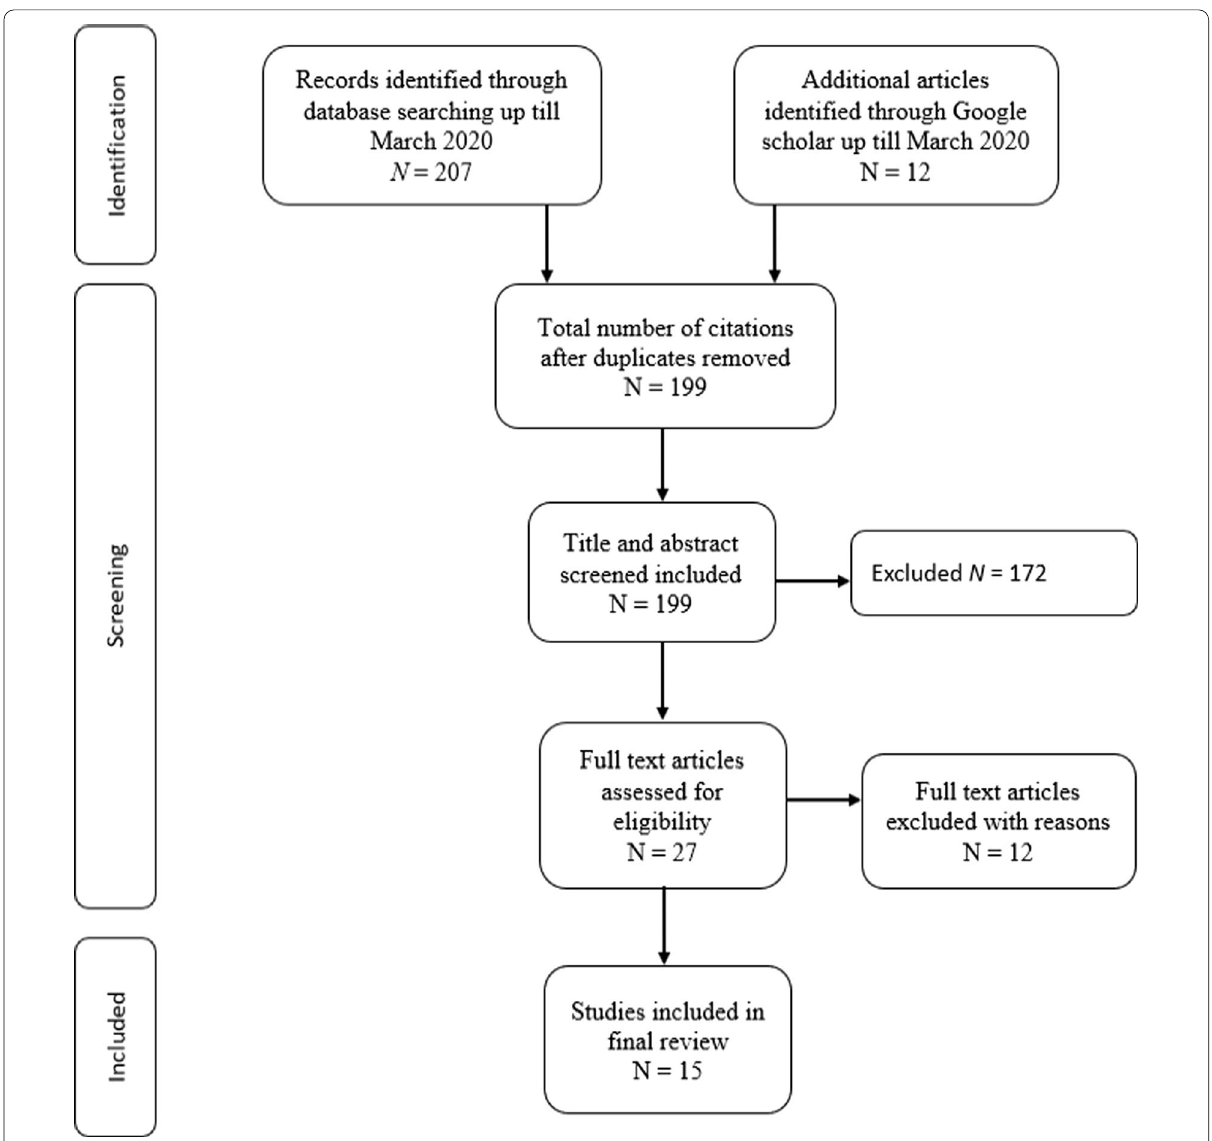
Fig. 1 Flow diagram for the s earch